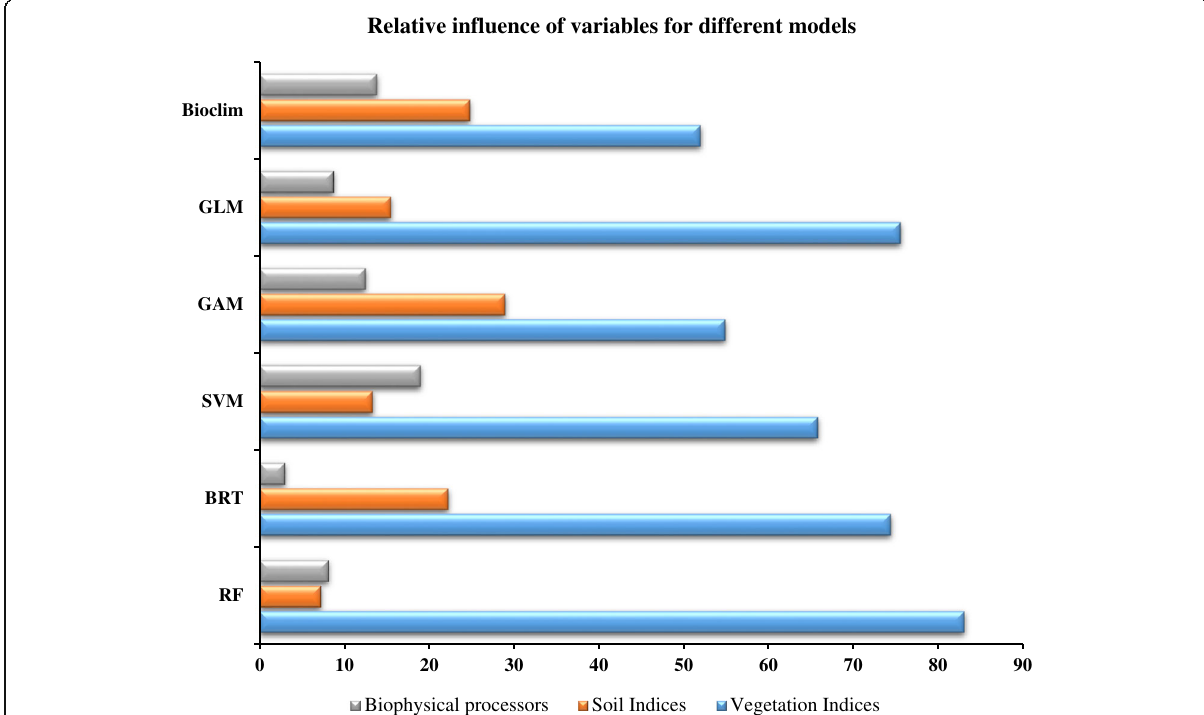
Fig. 6 The relative influence of predictive variables (vegetation indices, soil indices, and biophysical variables) for different models. The blue, red, and gray colors describe the weighted mean influence of vegetation indices, soil indices, and biophysical variables,